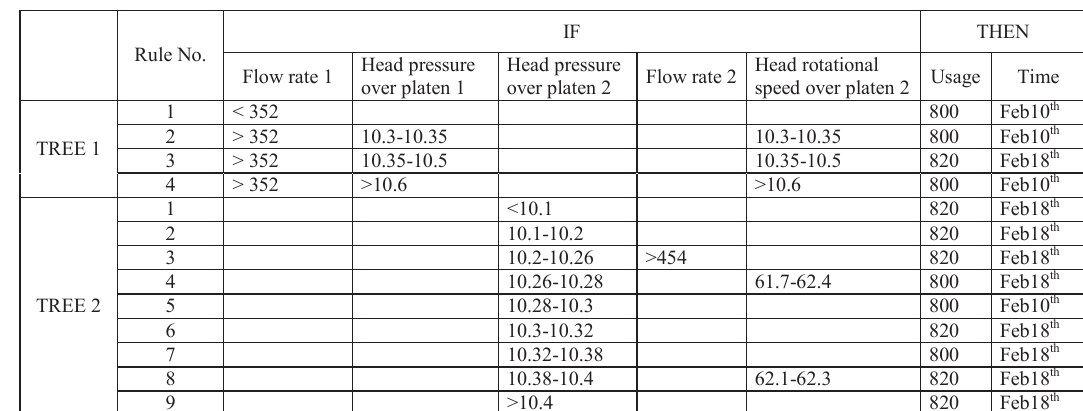
Table 6. Decision Rules for Stage